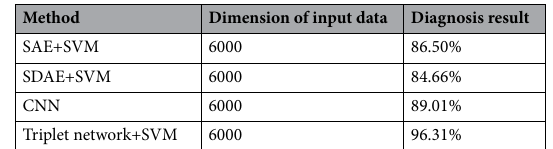
Table 2. Test accuracy of each